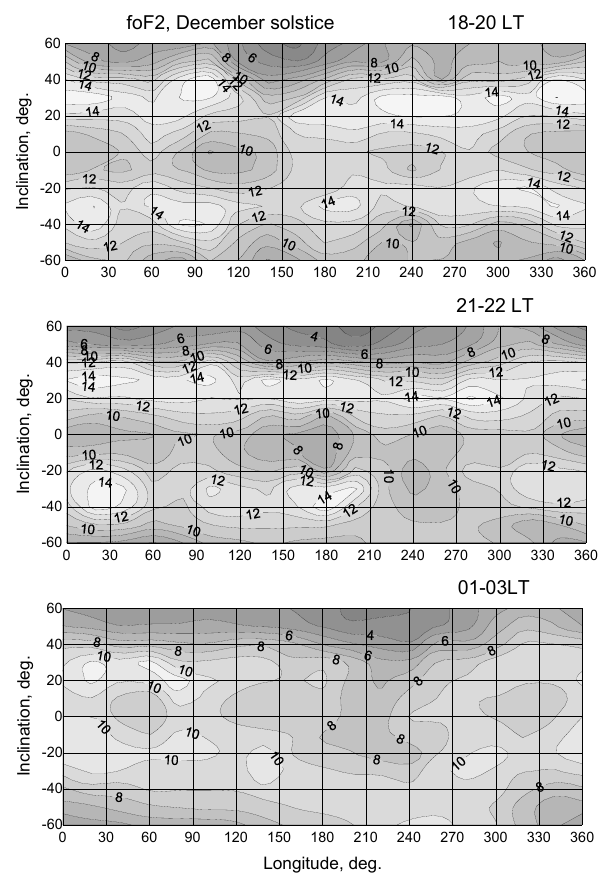
Fig. 2 to the manuscript by G.F. Deminova "Maps of foF2, hmF2, ..."